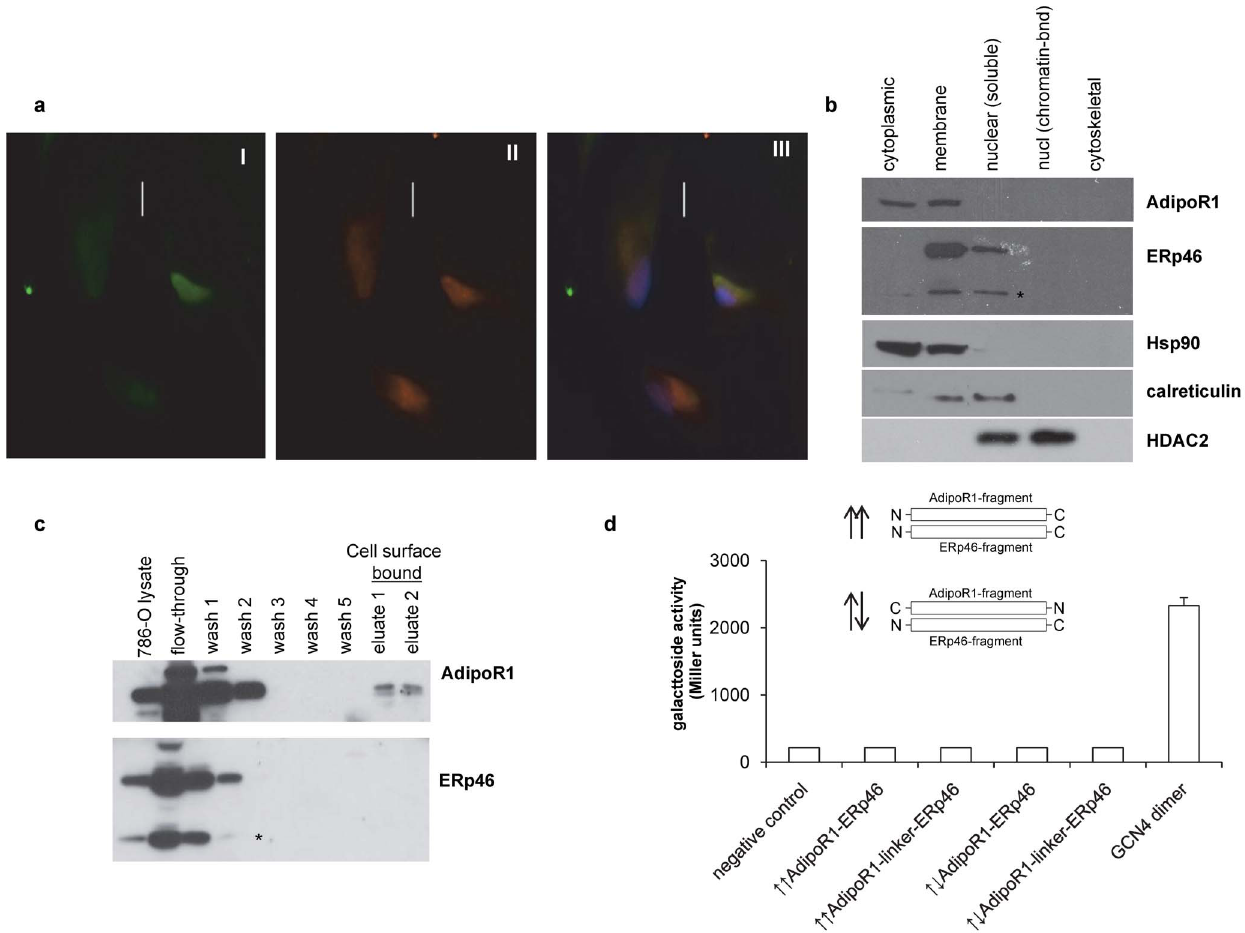
Figure 3. Co-localization of ERp46 and AdipoR1 in human ccRCC 786-O cells, but no interaction. ( a ) Immunocytochemical staining for ERp46 (I, green), or AdipoR1 (II, red). The merged image (III) demonstrates yellow signal which indicates co-localization. Cells were counterstained with DAPI (blue). ( b ) Subcellular protein fractionation. Equal portions of each fractionated cellular extract were analyzed by Western blot using specific antibodies against AdipoR1 and ERp46. Antibodies directed against Hsp90 (cytoplasmic), calreticulin (plasma membrane) and HDAC2 (nuclear) served as fractionation controls. AdipoR1 is detected in the cytoplasmic and plasma membrane fractions, ERp46 in the nuclear soluble and membrane fraction. The asterisk indicates an ERp46 degradation product or possibly the shorter ERp46 isoform 3. ( c ). Western blot analyses for AdipoR1 and ERp46-specific extraction and isolation from 3 6 10 6 786-O cells. Presence of AdipoR1 in the elution fraction confirms that AdipoR1 is cell surface exposed. Absence of ERp46 in the elution fraction indicates most likely that it is either not cell surface exposed or not tightly bound to a cell surface protein. ( d ) Bacterial adenylate cyclase-based two-hybrid assay (BACTH) used to determine the interaction between ERp46 and AdipoR1. The N-termini of AdipoR1 and ERp46 were expressed as fusion to the T18 and T25 domains of the adenylate cyclase. Interaction was quantified via cAMP/ CAP-induced b -galactosidase activity. The pUT18C strain producing AdipoR1 N fused to T25 domain of adenylate cyclase served as negative control. Other controls (plasmid, ERp46 N with linker, ERp46 N fused to T18) were also negative. No interaction between the N-termini of ERp46 and AdipoR1 was observed. T18 and T25 fused to interacting leucine zippers from GCN4 served as positive control. Data are from three independent repetitions and error bars indicate standard deviation. Depending on the fusion direction of AdipoR1 N and ERp46 N to T18 and T25, a ‘‘parallel’’ and ‘‘anti-parallel’’ orientation of the N-termini is captured, shown schematically.